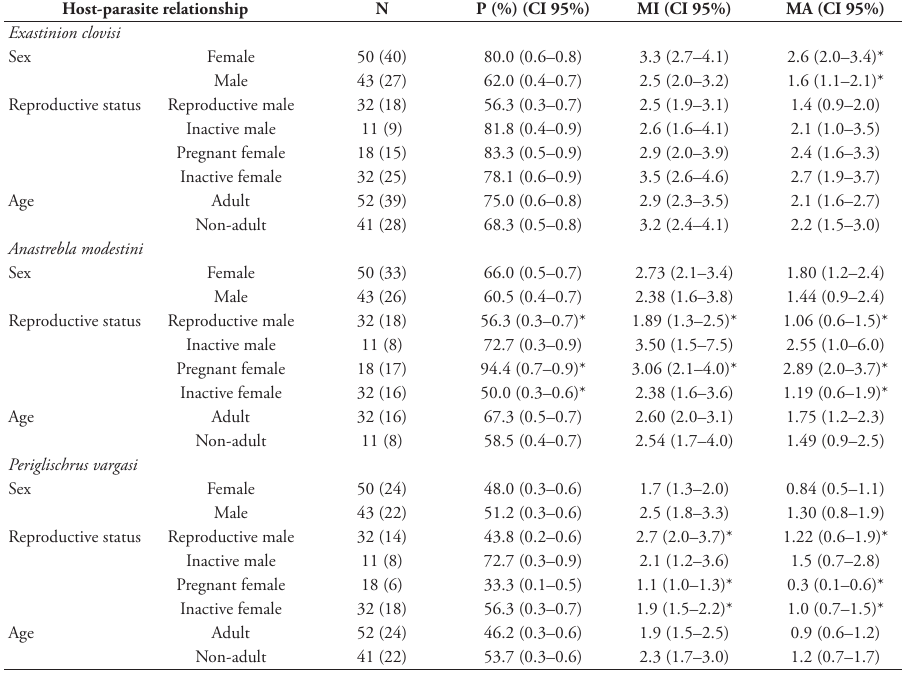
Table 2. Number of hosts examined (N), infected (in parentheses), Prevalence (P), Mean Intensity (MI) and Mean Abundance (MA), with Confidence Intervals (95% CI), for specific interactions of Exastinion clovisi , Anastrebla modestini and Periglischrus vargasi with Anoura geoffroyi in Piedade cave, located in Serra da Piedade, state of Minas Gerais. Inactive males had poorly developed testes and inactive females were those who did not show evidence of pregnancy and lactation. * = Significant